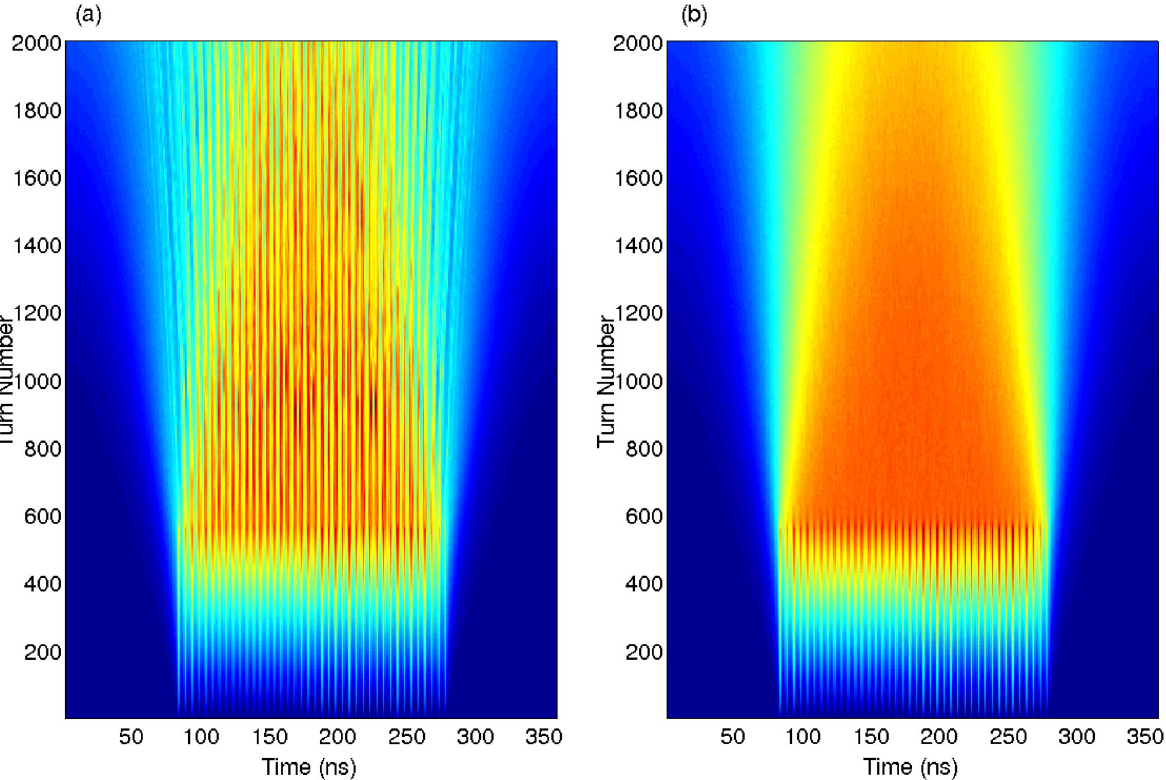
FIG. 5. (Color) (a) Waterfall plot of simulated wall current monitor signal for chopped beam experiments. Space-charge effects are included. (b) Same as in (a) but with no space charge